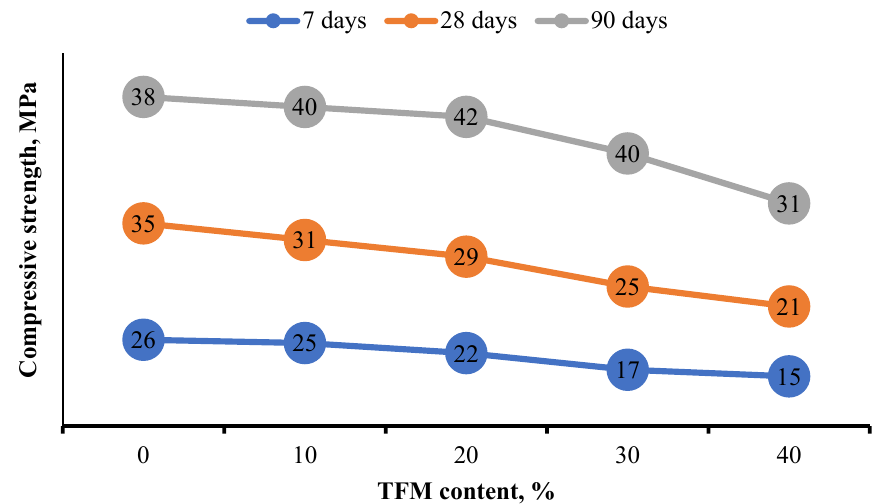
Figure 8. Dependence of concrete compressive strength on the consumption of additive TFM.